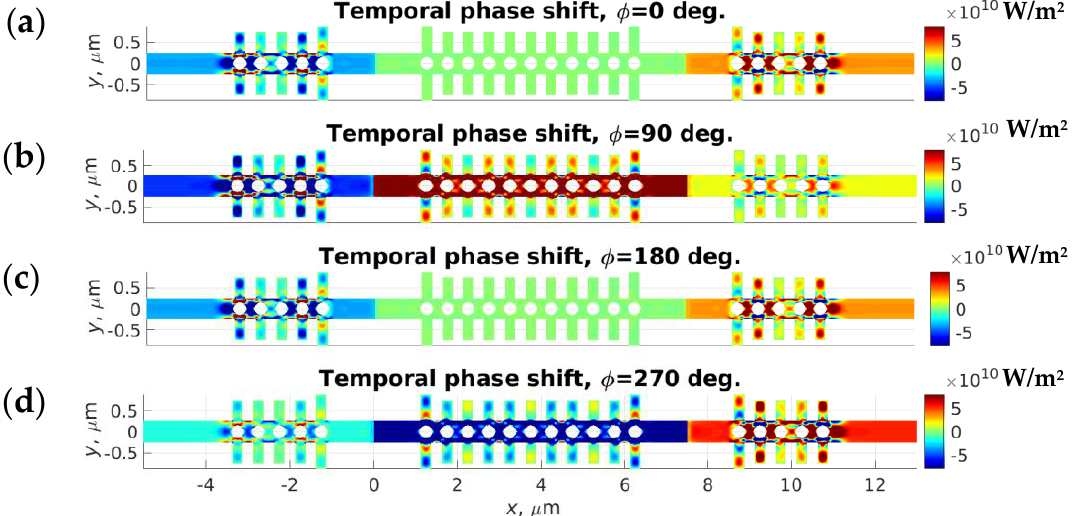
corresponding to N cells in panel ( a ) for two cavities linked directly in quasi 1D-periodic phononic crystal. ( c ) The mass density profile of the two cavities linked through a straight phononic waveguide of length D . ( d ) Resonant wavelength as function of length D of middle layer (corresponding to a straight phononic beam) in panel ( c ) that connects the two crystals containing the cavities.